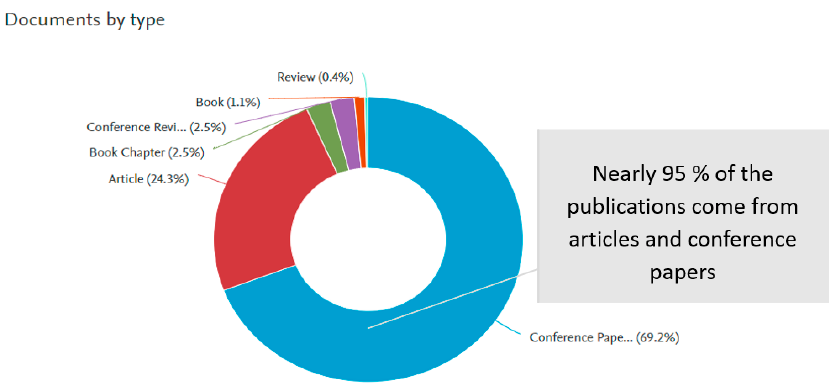
Figure 3. Agile AND transformation AND manufacturing—Documents by Type.